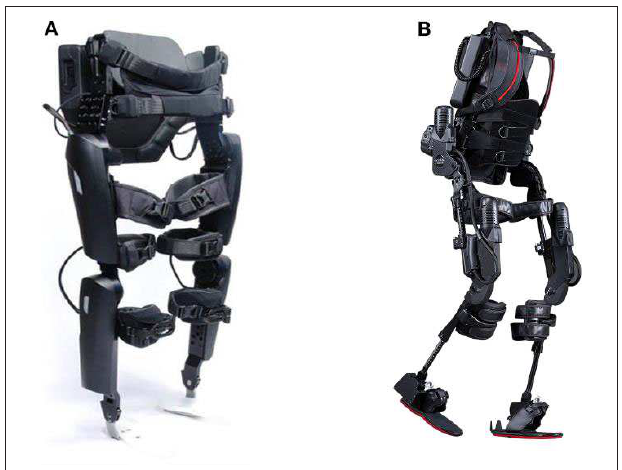
FIGURE 1 | Exoskeletons used in this study: (A) ReWalk (ReWalk Robotics, Inc. Marlborough, MA, USA) and (B) Ekso GT (Ekso Bionics, Richmond, CA,